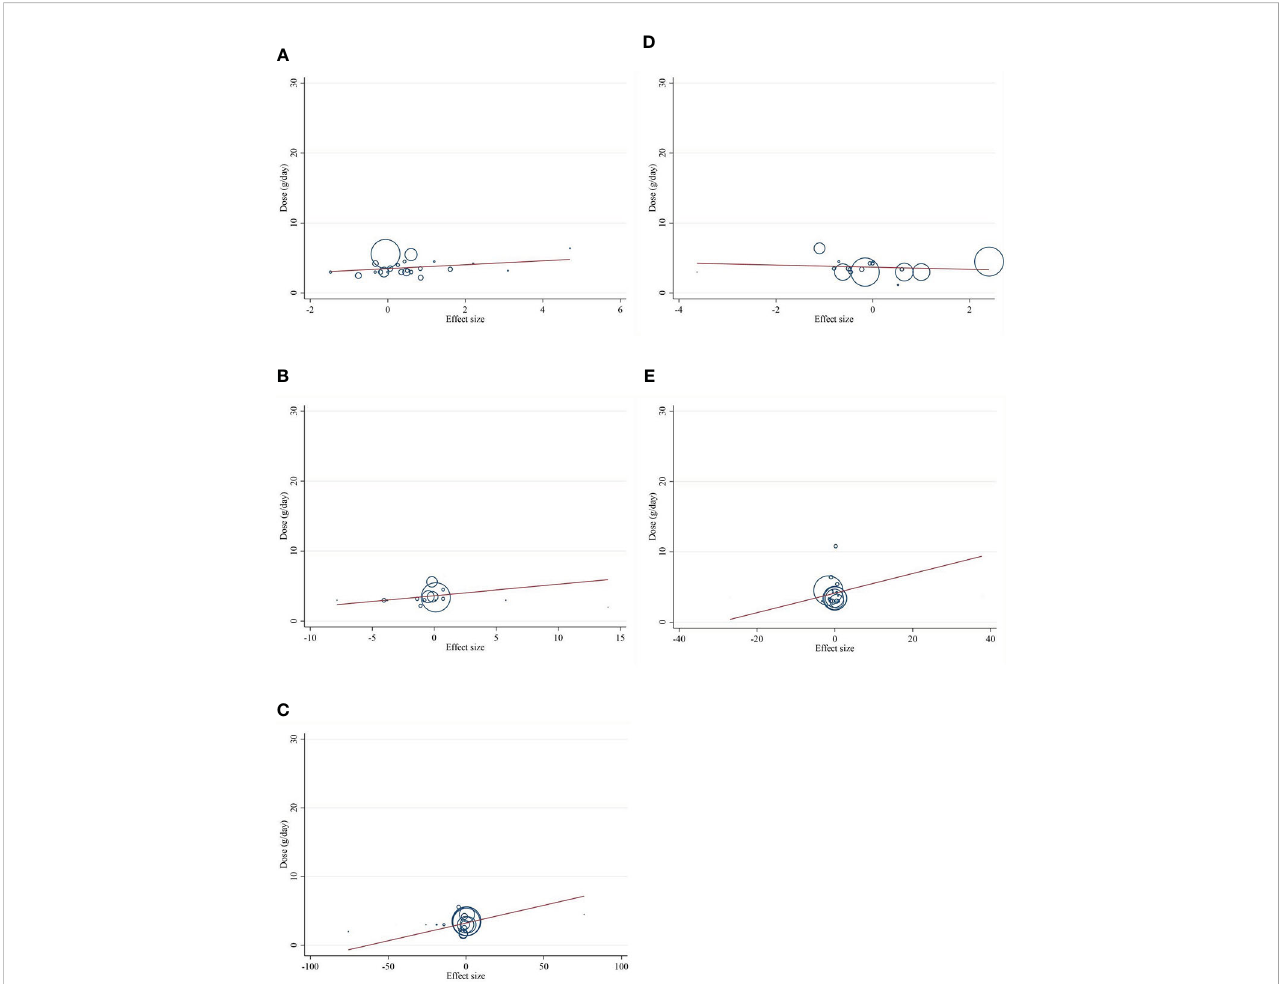
FIGURE 6 Random-effects meta-regression plots of the association between dose of CLA (mg/day) and weighted mean difference of (A) CRP (mg/L), (B) IL-6 (pg/ ml), (C) TNF- a (ng/ml), (D) adiponectin (µg/ml), and (E) leptin (ng/ml). Horizontal lines represent 95% CIs. Diamonds represent pooled estimates from random-effects analysis. WMD, weighted mean difference; CI, con fi dence interval; CRP, C-reactive protein; IL-6, interleukin 6; TNF- a , tumor necrosis